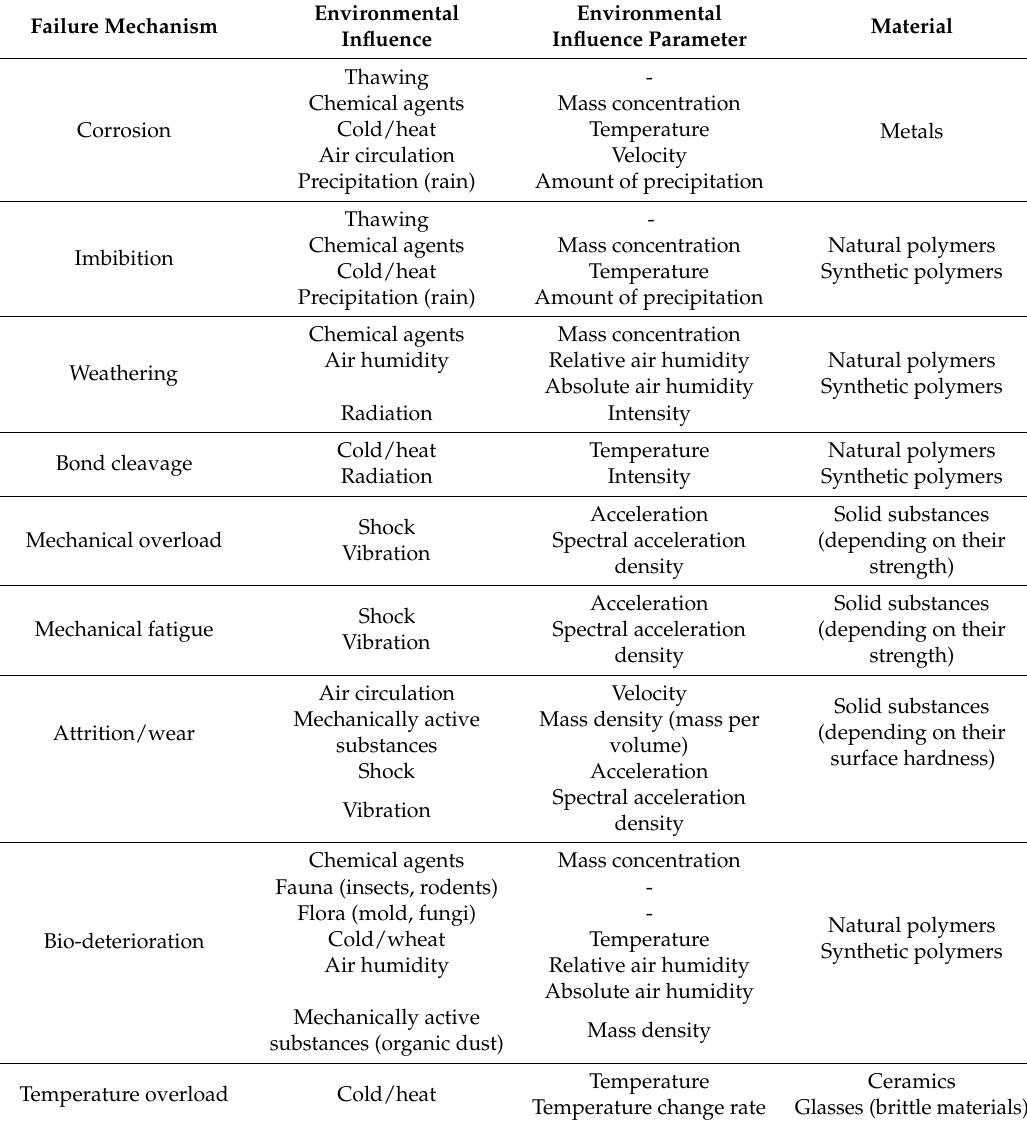
Table A4. Failuremechanismsandtheir relationto environmental influencesandtomaterial